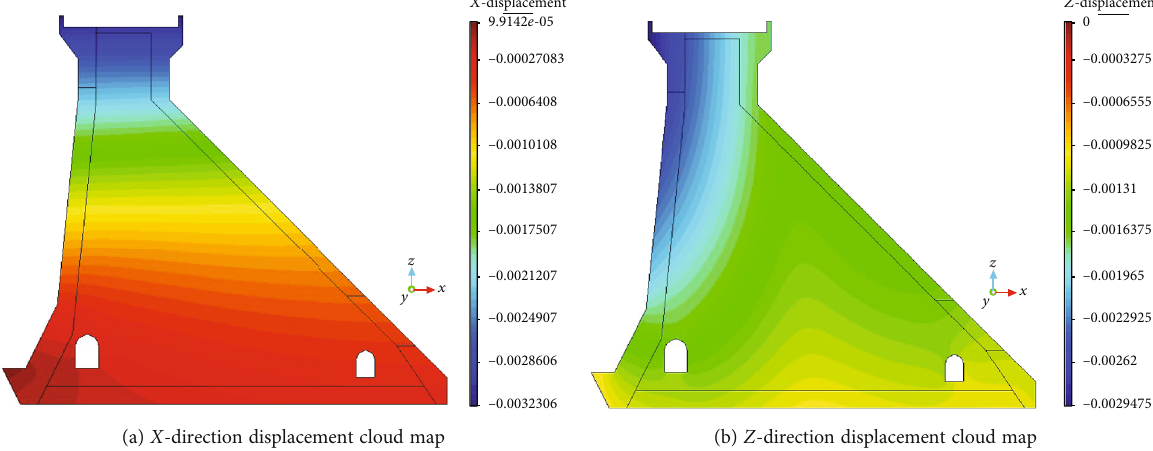
Figure 6: Displacement cloud diagram of dam retaining section under static and dynamic superposition (static+dynamic)